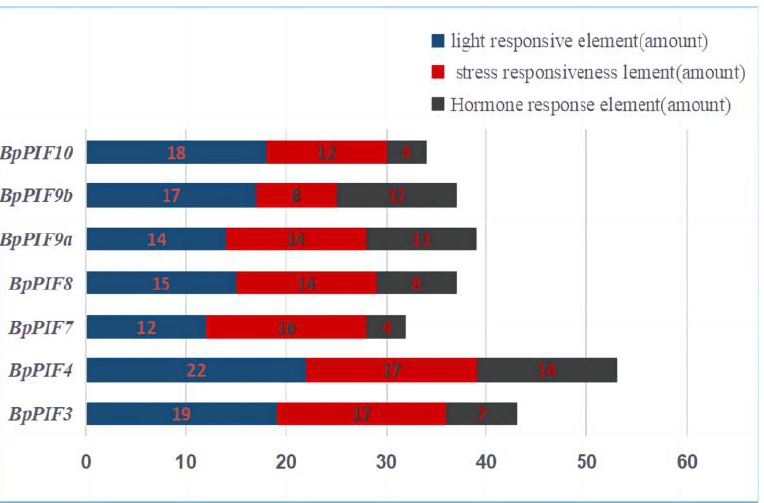
Figure 4. Putative conserved motifs in the promoters of BpPIFs according to the phylogenetic relationship. The three motifs were identified online using the MEME with a 2.0 kb upstream region of the start codon of all BpPIF genes. The following parameters “nmotifs 3, minw 6, maxw 20, minsites 30, maxsites 100” were used in MEME. Different colours indicate different motifs. The logos of three conserved domain sequences, shown in the top right corner, were obtained from the MEME Suite website.